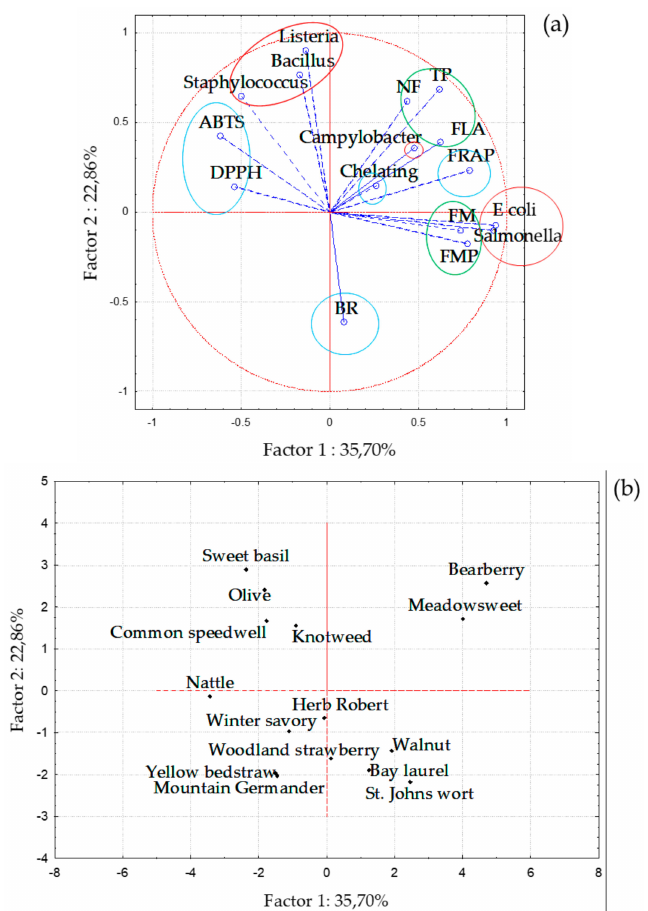
Figure 2. Principal component (PC) analysis of plant extracts based on PC1 and PC2 scores; loading plots of ( a ) investigated parameters, and ( b ) plant